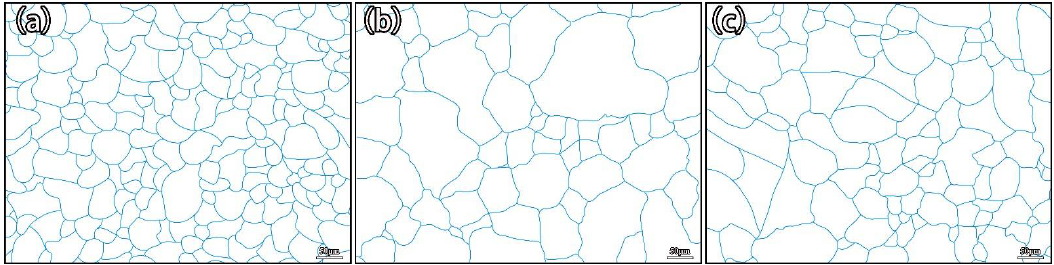
Figure 13. Fitted image of grain size: ( a ) process L2; ( b ) process L4; ( c ) process N.